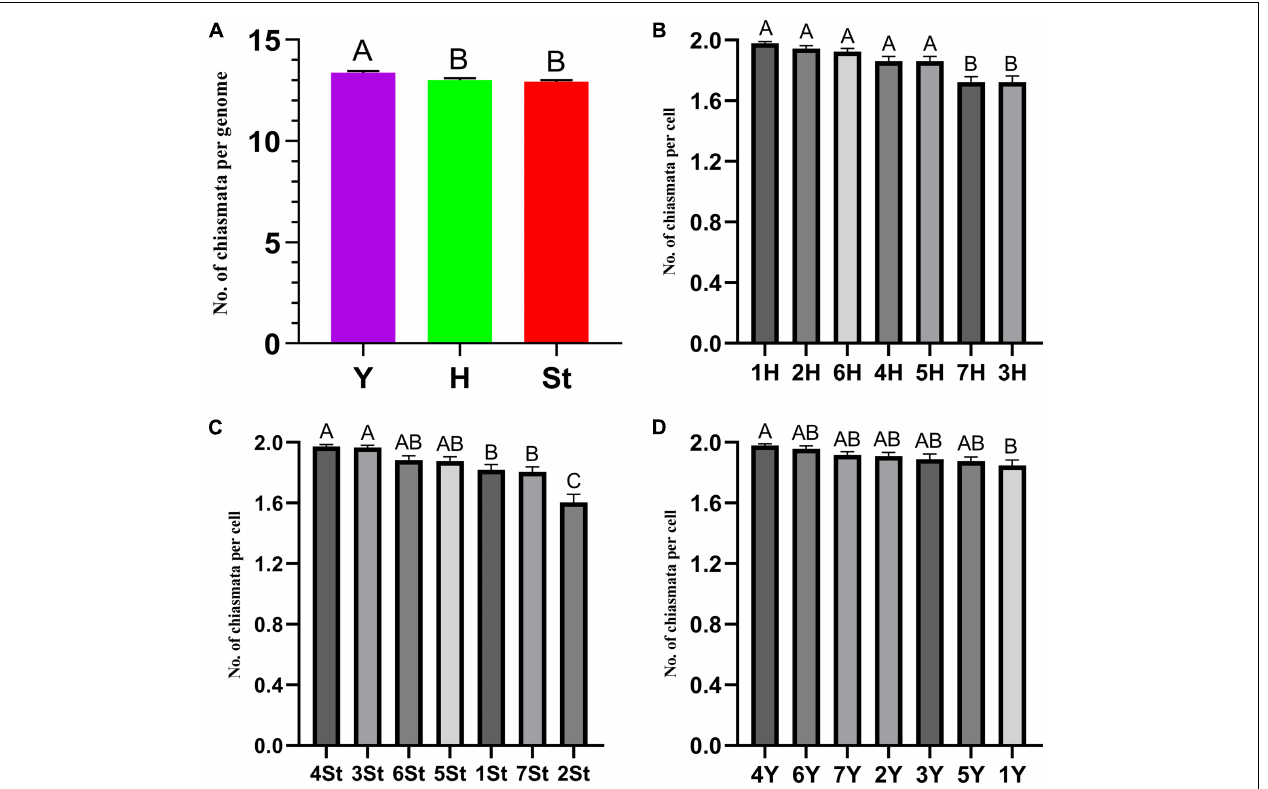
FIGURE 6 | ANOVA of chromosome chiasmata number. (A) Between genomes; (B–D) within genomes. Experimental data are presented as the mean ± standard error of the mean. The different Roman letters in the superscript of each column indicates that the difference between the two means is very significant ( p <